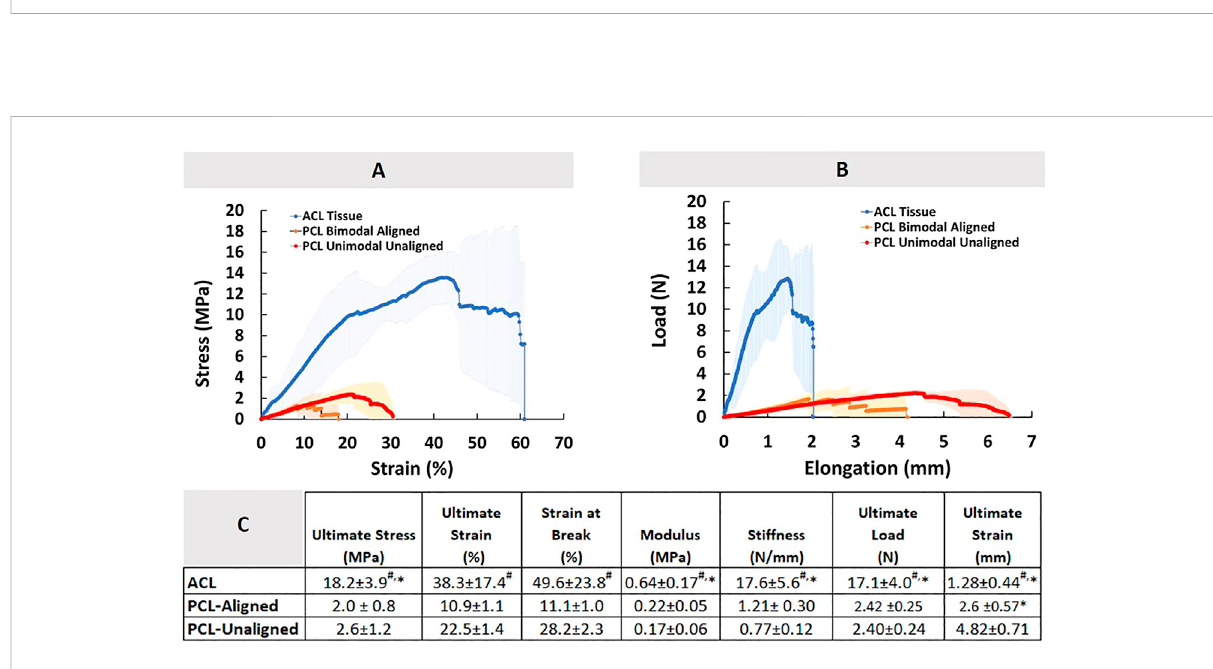
FIGURE 8 ComparisonofNativeACLtissueandPCLconstructsintermsofmechanicalproperties. (A) Stress-straindiagram, (B) Load-elongationdiagram, and (C) descriptive statistics. An * indicates signi fi cant difference from PCL-Aligned, and # indicates signi fi cant difference from PCL-Unaligned at p < 0.05. Error bars represent